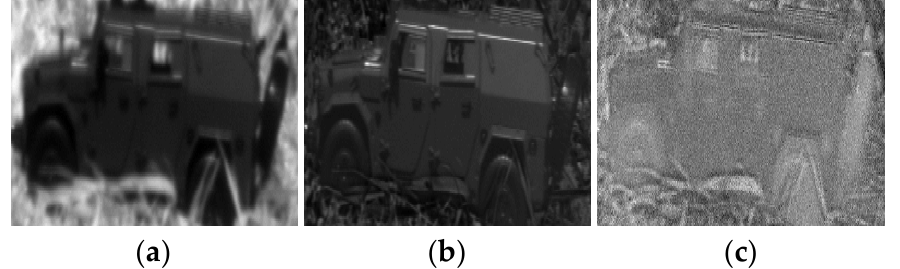
Figure 16. The first three principal component images of area B to be tested after PCA. ( a ) The first principal component image of area B, ( b ) The second principal component image of area B, ( c ) The third principal component image of area B. The commonly used curve similarity evaluation index parameters are used to measure the spectral similarity of two objects at the same pixel position after processing. The spectral angle metric (SAM) method [13] is a typical similarity measurement method based on projection. Its value corresponds to the cosine angle between the two curves, reflecting the shape difference between spectral curves. Root mean square error (RMSE) [14] is a typical distance-based similarity measurement method, which reflects the difference of spectral vector size between the two places. The two methods are used to evaluate the similarity of the original image data, the data after the PCA of the whole image and the data after the PCA of the area to be tested. The results of the first group of experiments are shown in Table 1. The results of the second group of experiments are shown in Table 2. Table 1. Similarity comparison between camouflage clothing and grassland. Based on Raw The Whole Image The Area to Be Image Data after PCA